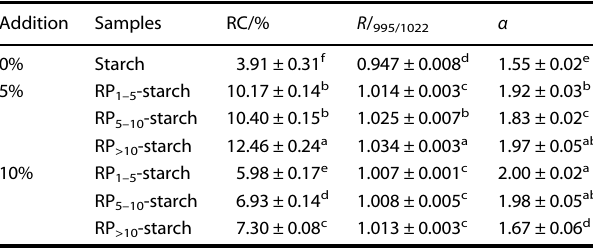
Each value is the mean of three replicates. For the same column, data with same letters do not differ signi fi cantly from each other whereas data with different superscripts differ signi fi cantly at the probability level p